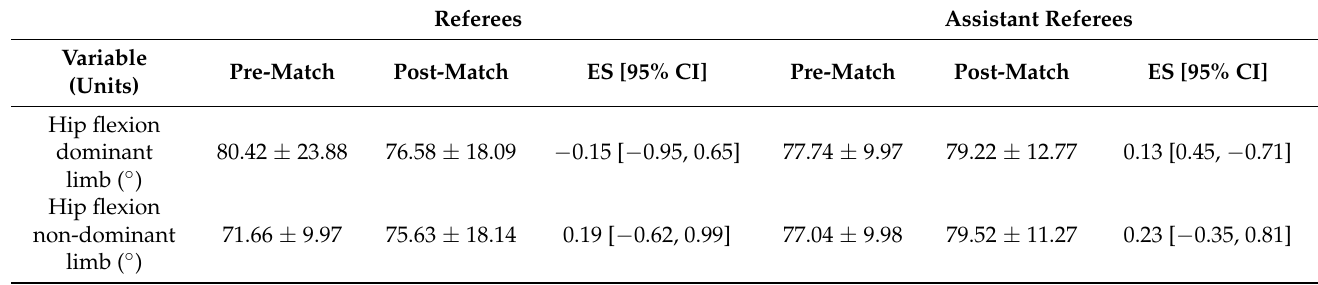
Table 2. Hip flexion range of motion in referees and assistant referees before and after officiating an official football match. Referees Assistant